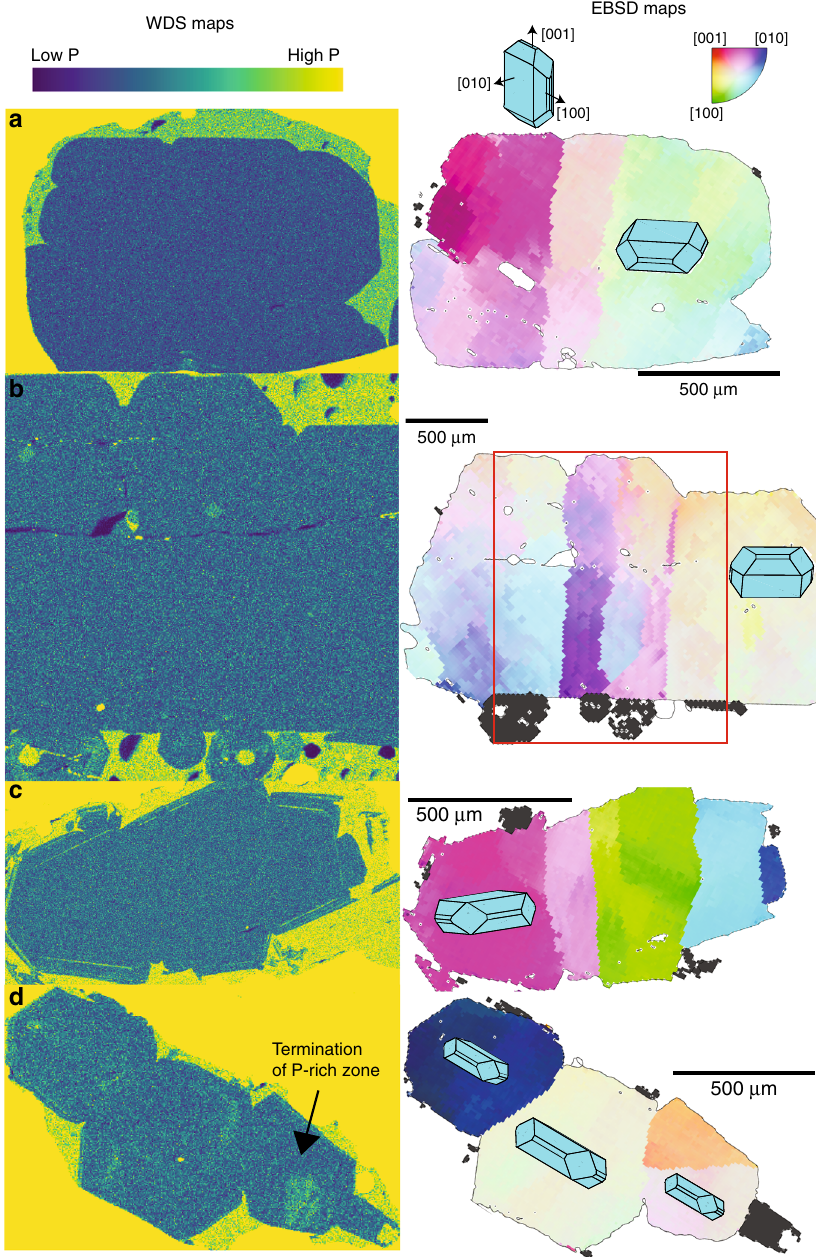
Fig. 2 Relationships between minor element enrichments and lattice distortions. Wavelength dispersive spectrometry (WDS) maps of P enrichment compared to electron backscatter diffraction (EBSD) maps (scale for both images shown on EBSD map). a – c Grains with internal lattice distortions (revealed by stripes of different colors in EBSD maps) have homogeneous concentrations of P in their cores (see WDS maps). Observed phosphorus enrichments in the rim of the crystal shown in c likely mark a period of rapid growth upon eruption. d Internal P enrichments are truncated against a subgrain boundary. WDS elemental maps are colored by the number of counts per pixel (in ImageJ). EBSD maps are colored using the inverse pole fi gure (IPF) key. A color reference direction is chosen such that the mean orientation of the central grain is colored white. The coloring denotes the misorientation axis and angle of each pixel relative to this reference direction. To emphasize small misorientations, the IPF key has been shrunk so that all the color variation is distributed across misorientation angles of 0 – 3°. For example, pixels misoriented about [010] by 3° from the mean orientation are colored dark blue (see the color scale, top right). Pixels misorientated by >3° are colored black. Light blue 3D olivine crystals are superimposed (using the MTEX crystalShape package) to allow visualization of the orientation of the three crystallographic axes ([100], [010], and [001], for space group (Fig. 5a, b), with statistically signi fi cant differences for individual chemistry of deformed and undeformed grains 6,38 , along with eruptions ( p < 0.01, Kolmogorov-Smirnov test, Fig. 5c – f). Dif- ferences in minor element compositions have also been reported euhedral grain outlines, has led to suggestions that deformation for deformed and undeformed grains erupted at K ī lauea Iki 27 . results from grain collisions during magma fl ow through con- stricted conduits 10,11 . However, deformed grains examined in this Finally, deformed olivines in different eruptions have similar study have higher forsterite contents than undeformed grains forsterite contents, which are signi fi cantly out of equilibrium with